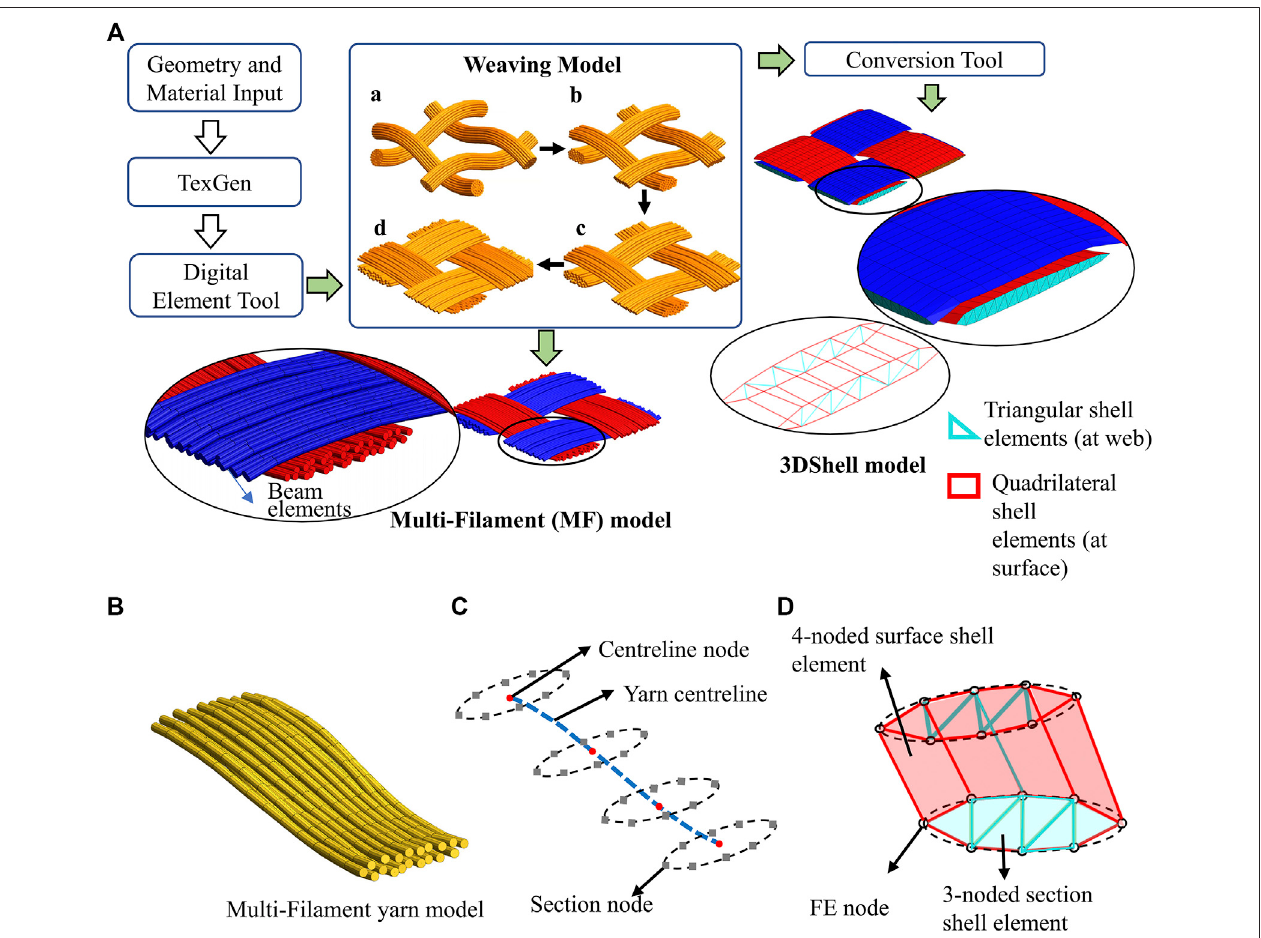
FIGURE 2 | (A) : Multiscale modelling process of 2D woven fabric geometric modelling from weaving model to multi- fi lament and 3DShell model (Mahadik and Hallett,2010a;GreenandLong,2014). (B) :TheMFmodelofasingleyarninunitcellsize. (C) Yarngeometryrepresentationand (D) yarncrosssectionFErepresentation.